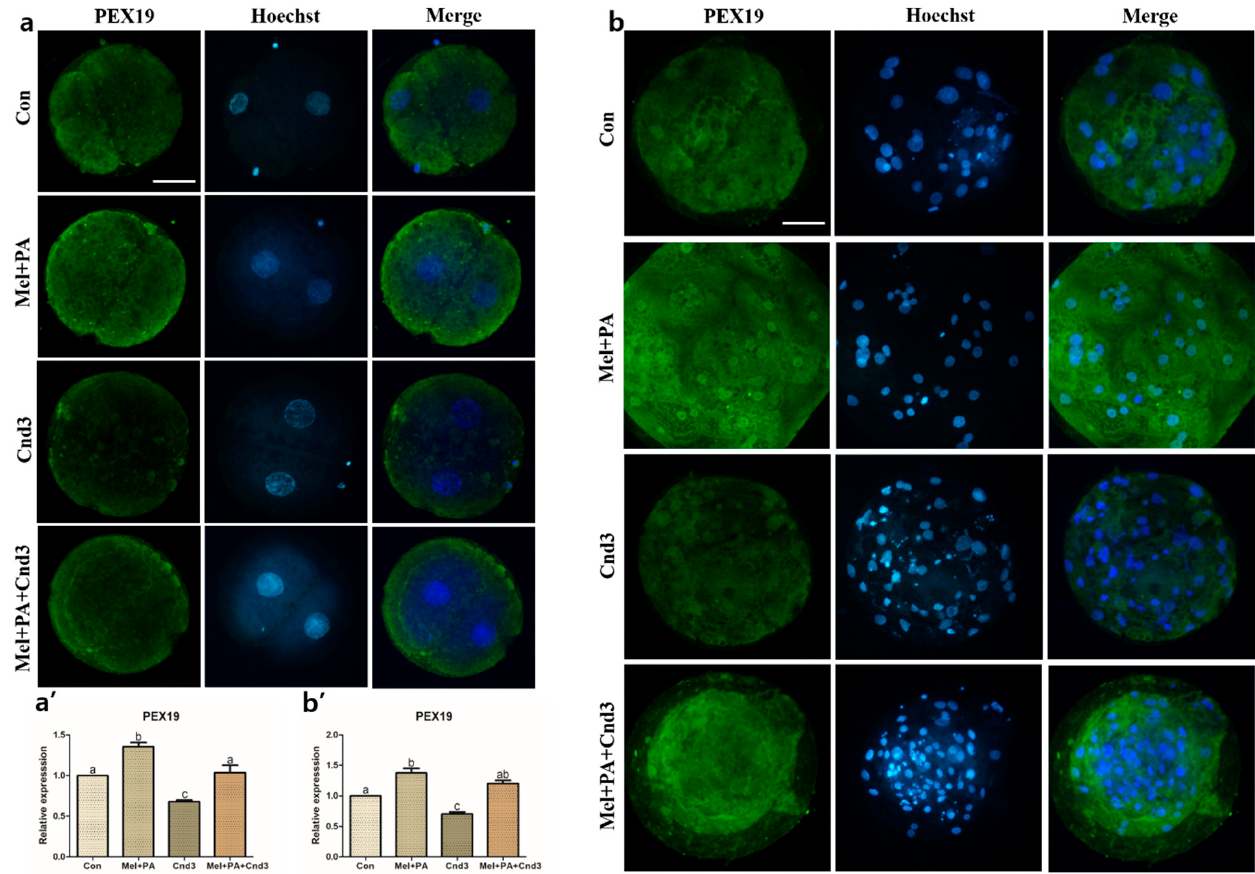
Figure 5. Representative images of immunocytochemical analysis of PEX19 in porcine two-cell embryo blastocysts. Fluorescence microscopy was applied to obtain images of embryos. ( a , b ) Representative two-cell embryos in each group were stained with PEX19 rabbit-derived antibody and counterstained with Hoechst 33342. ( a’ , b’ ) Analysis of intensities from PEX19-stained two-cell embryos and blastocysts. At least 20 two-cell embryos and 15 blastocysts from five biological replications in each group were used for the staining and immunocytochemistry was performed three times technically. Data are shown as the means ± SEM. Bars with different alphabetical letters are significantly different ( p < 0.05). Con, control; mel, melatonin, PA, phytanic acid; Cnd3, siRNA candidate 3. White bars in the images indicate 50 µ m; 400 × magnification.